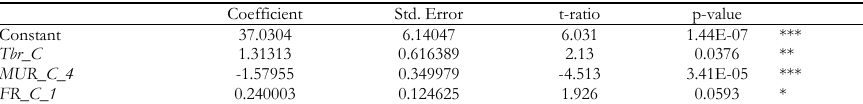
OLS in Central regions of Italy (adj. R 2 = 0.65)